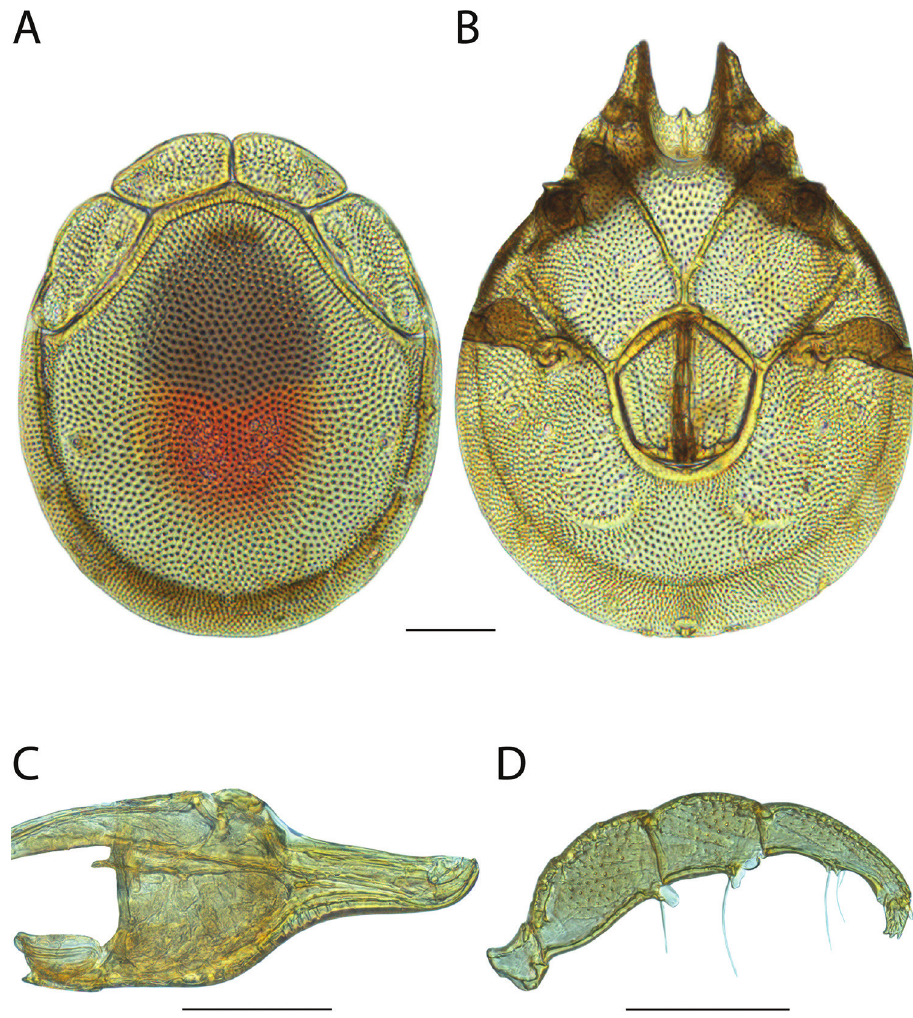
Figure 118. Torrenticola kringi sp. n. female: A dorsal plates B venter (legs removed) C subcapitulum D pedipalp (setae not accurately depicted). Scale = 100